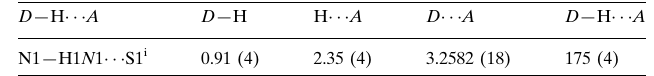
Hydrogen-bond geometry (A˚ , (cid:2)